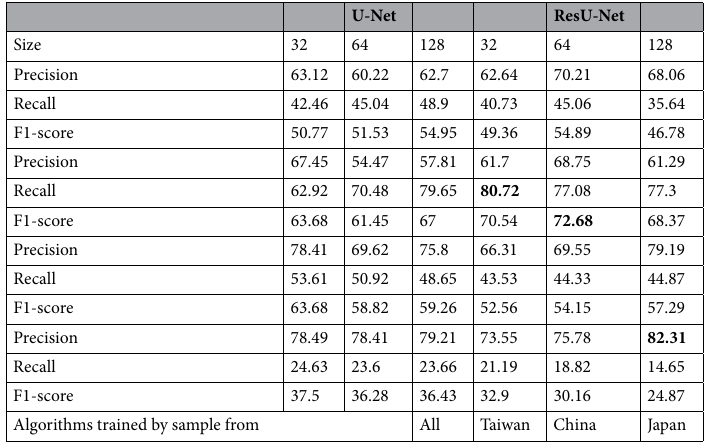
Table 5. The resulting precision, recall, and f1-score values for Scenario 2 (training the algorithms with the training dataset of Taiwan and testing it on the Taiwan, China, Japan, and all test datasets separately). The highest values of precision, recall, and f1-score are indicated in